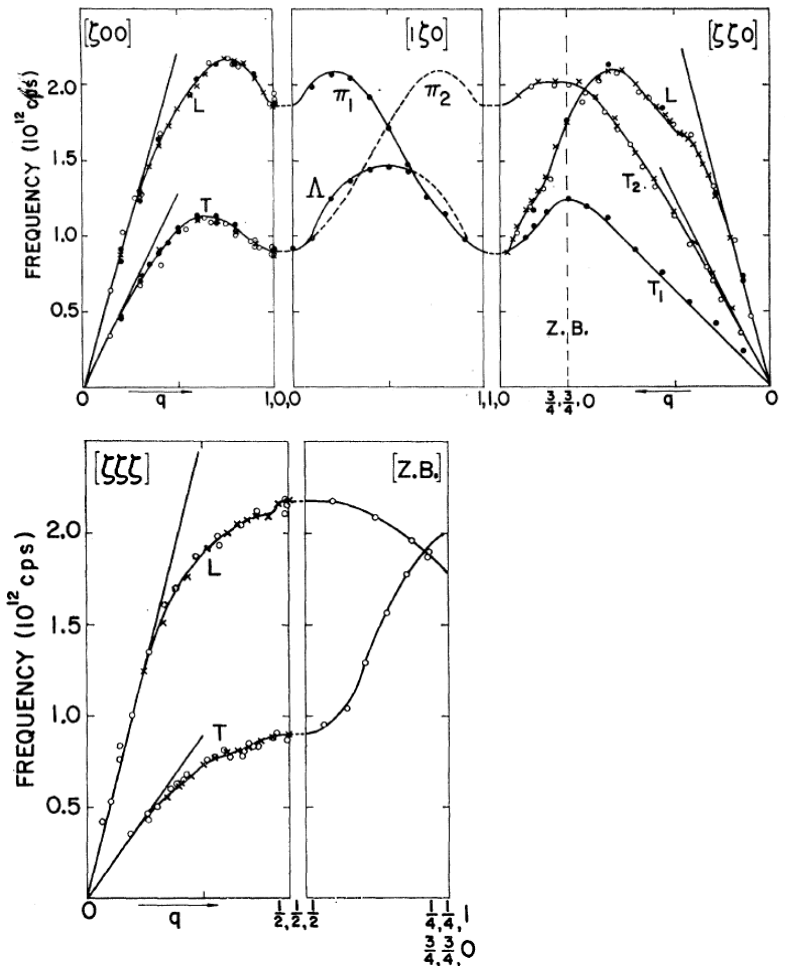
Figure 20. The phonon dispersion relations in lead at 100K for high-symmetry directions. The open circles were obtained by the constant- k method in the (110) plane and the closed circles were obtained by the constant- Q method in the {100} plane. The straight lines through the origin give the initial slopes of the curves as calculated from the elastic constants. This figure is taken from Figure 5 of ref. [60]. Copyright by the American Physical Society.